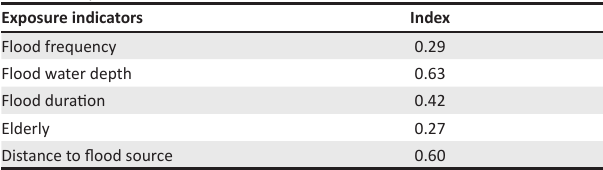
TABLE 4: Exposure index.